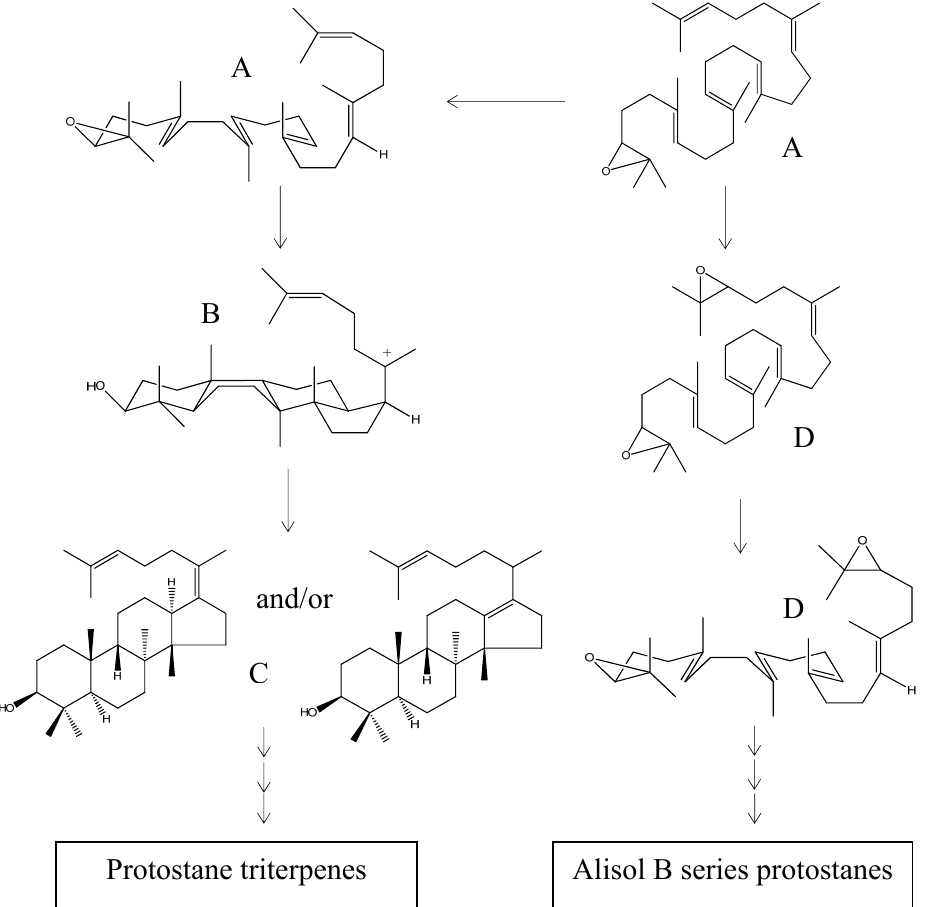
Scheme 1. Proposed biogenetic sequence of protostanes. A: 2,3-( S )-oxidosqualene;